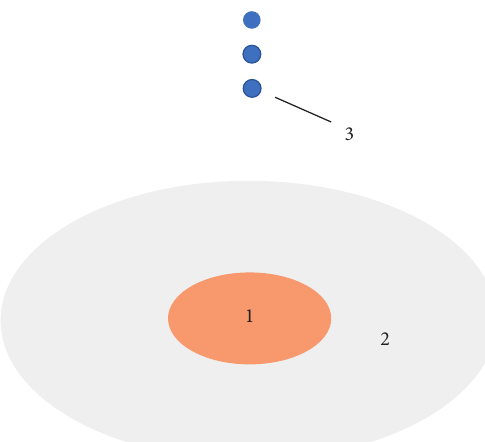
Figure 1: Relationship diagram of core/noncore knowledge and knowledge receiving enterprises in a knowledge alliance. 1, core knowledge; 2, noncore knowledge; 3, knowledge receiving